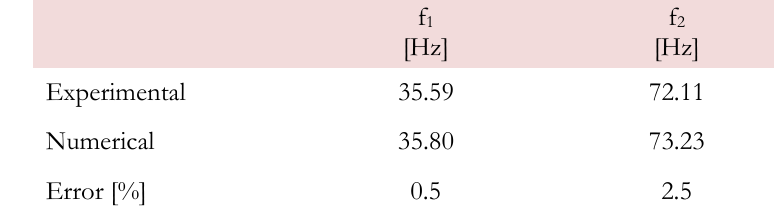
Table 1: Comparisons between the first two experimental and numerical natural frequencies. Fig. 2 shows the direct comparison between modal curvatures ''  , experimentally measured and numerically evaluated, plotted along the ratio s/s A , in which s and s A being the curvilinear abscissa and the total length along the arch centerline, respectively.